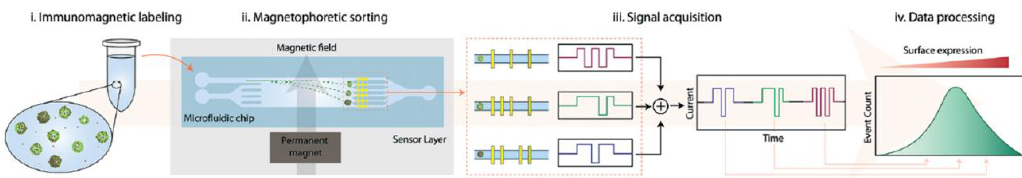
Figure 5. Device designed by Civelekoglu et al. [36] for cell sorting based on the expression of surface molecules. Immunomagnetically labeled cells are introduced to the microfluidic device from a single inlet. Sheath-flow-focused cells deflect in the transverse axis based on their magnetic load under an external magnetic field as they traverse the microfluidic chip. Cells sorted into different outlets generate digitally-coded electrical signals via a code-multiplexed Coulter counter array. The electrical signal is decoded to quantify the spatial distribution of cells, and an expression histogram is produced via computational analysis of sensor signals.